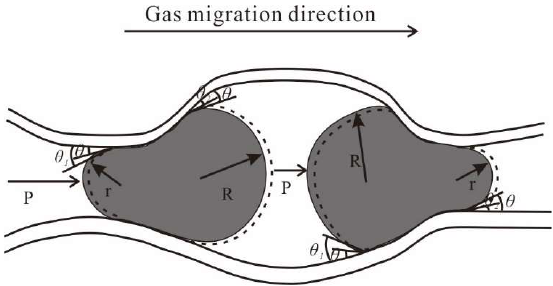
Figure 12. Hydrocarbon migration model under capillary pressure.